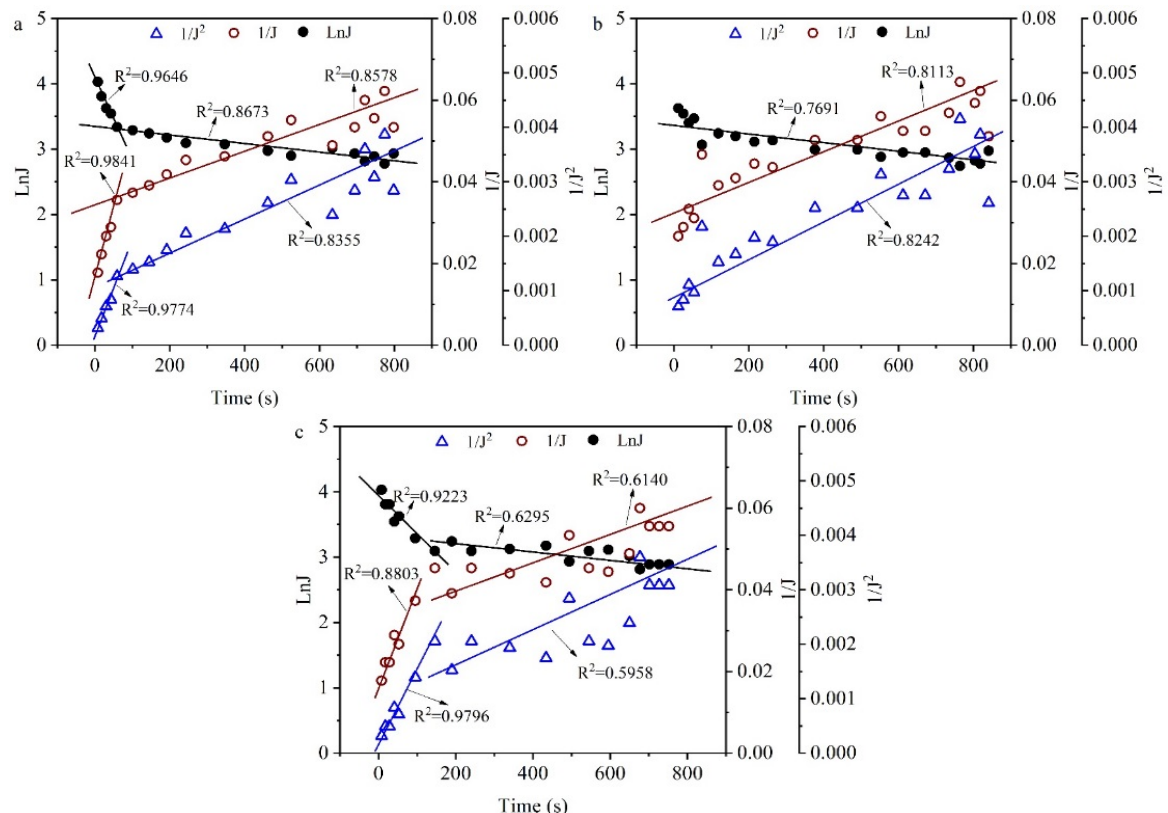
Figure 8. Determination of fouling mechanisms from model fitting to experimental data in Figure 7: ( a ) cycle 1, ( b ) cycle 2, and ( c ) cycle 3.